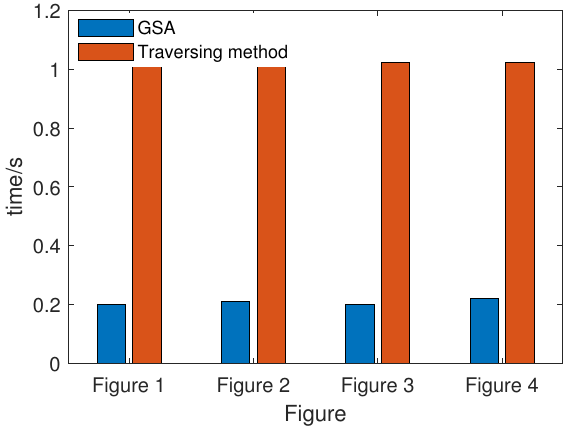
Figure 13. Comparison of the optimal values of optimization and traversal.